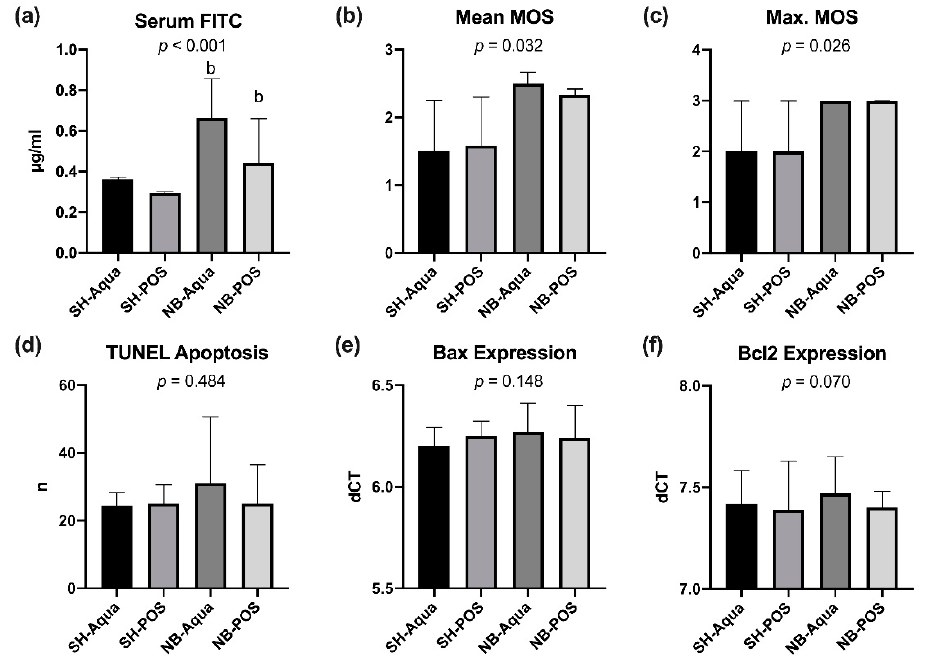
Figure 6. Analysis of bowel wall permeability; ( a ) serum FITC levels, ( b ) mean and ( c ) maximal